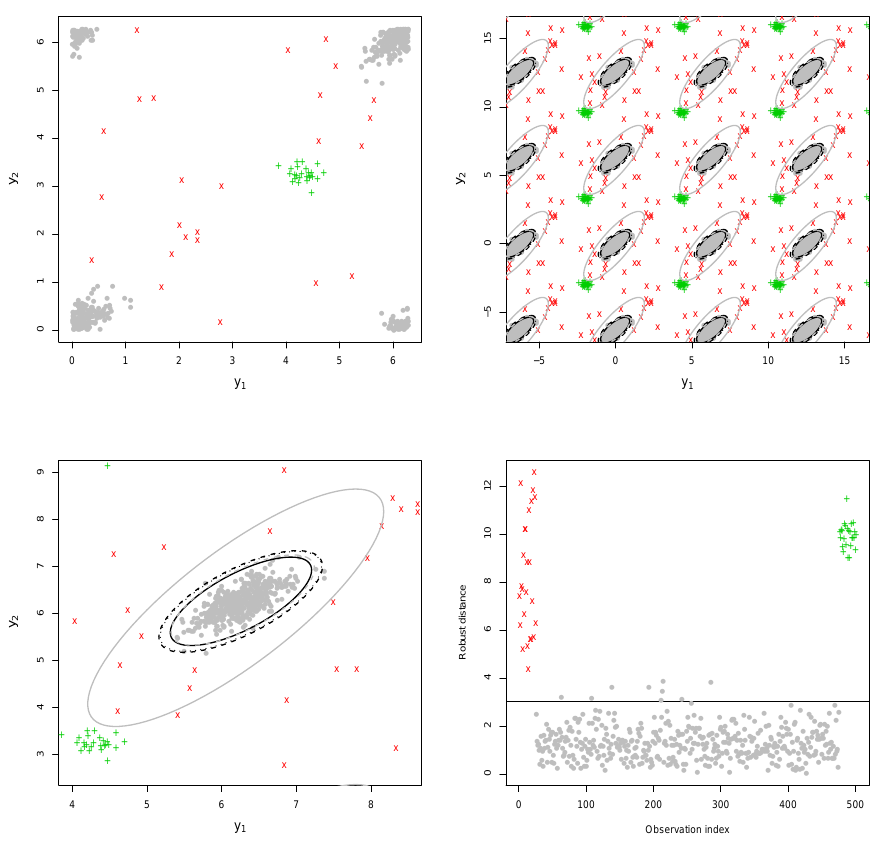
Figure 1. First synthetic example. Top-left : Original circular data. Top-right : Data, fitted models (WLE-solid line, trimming-dashed line, MM-dotted line, MLE-solid gray line) and true model (dashed gray line) on a flat torus. Bottom-left : Fitted tolerance ellipses. Bottom-right : Distance plot. Genuine data are in gray, scattered outliers in red, and clustered outliers in